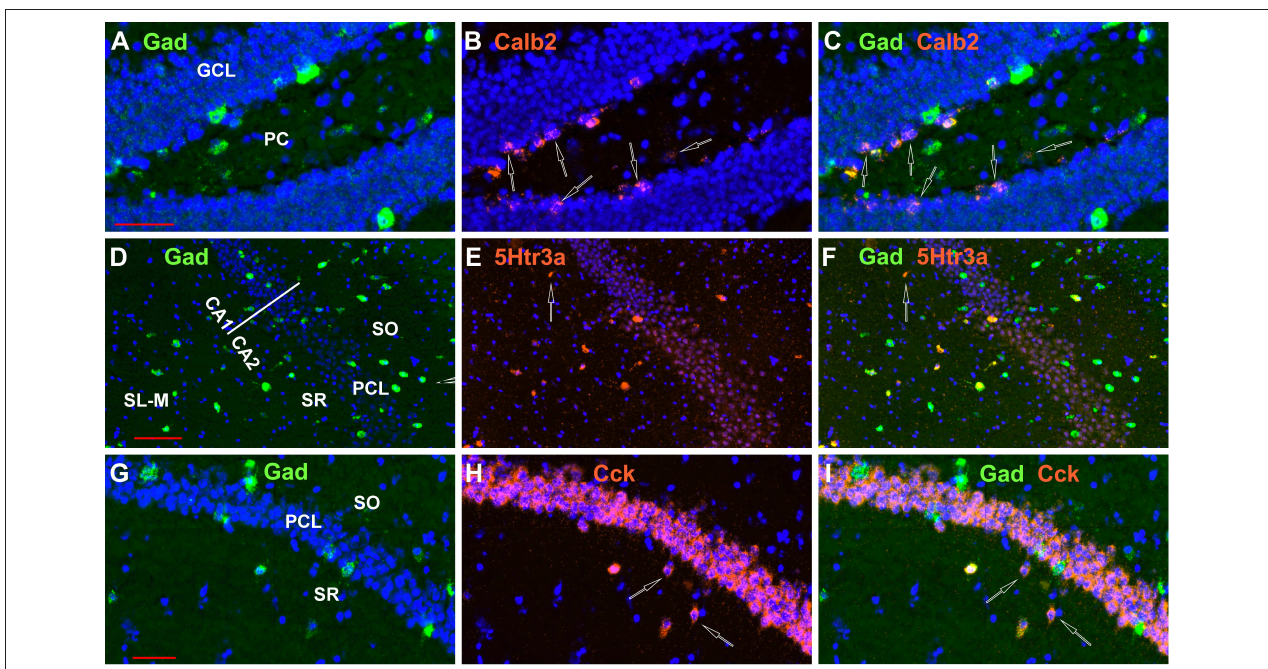
FIGURE 13 | Not all neurons examined expressing INMs in the hippocampus express Gad-1, although the great majority do. Examples of Calb2 neurons in the DG, a 5Htr3a neuron in CA1, and two Cck neurons in CA1 that do not express Gad-1 are indicated by the open arrows in (A–C,D–F,G–I) , respectively. Scale bars for (A–C,D–F,G–I) , are 50, 100, and 50 µ m,